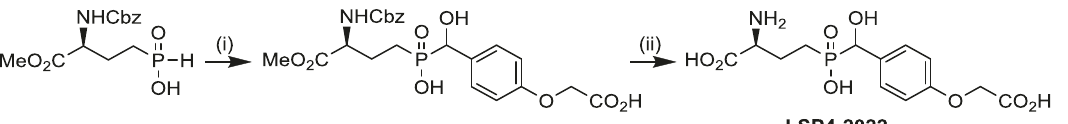
Fig. 9 Improved synthesis of LSP4-2022 a . a Reagents and conditions: (i) 4-(Carboxymethoxy)benzaldehyde, BSA, degassed CH 2 Cl 2 , RT, 16h; (ii) a 6M aqueous HCl, re fl ux, 5h; b C-18 fl ash chromatography. Abbreviations: BSA: N,O- bis(trimethylsilyl)acetamide; Cbz: benzyloxycarbonyl; L-AP4: